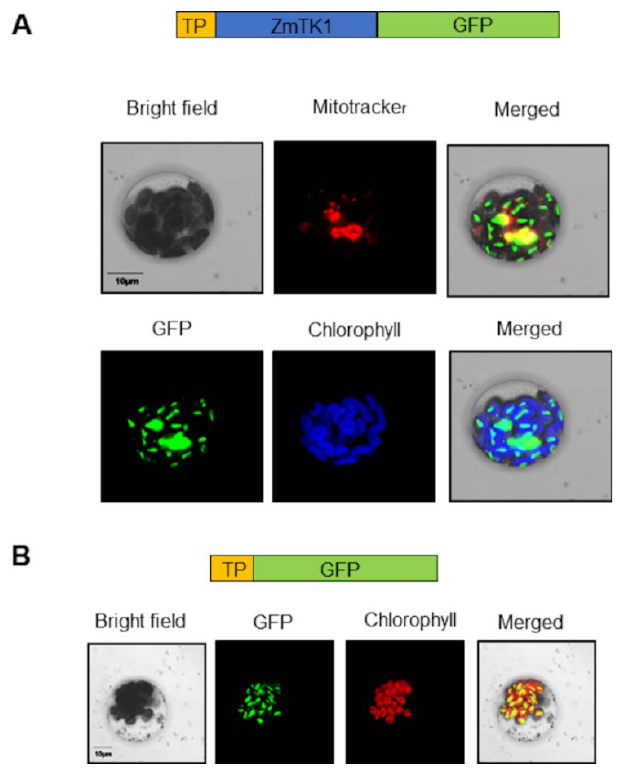
Figure 3. Transient expression of 35S::ZmTK1-GFP in Arabidopsis protoplasts. ( A ) Colocalization of green fluorescent protein (GFP) with mitotracker and chlorophyll fluorescence. ( B ) A 72-aminoacid sequence at the N-terminus of ZmTK1 (35S::TP-ZmTK1-GFP), drove GFP to the chloroplast. The bar represents 10 µm.